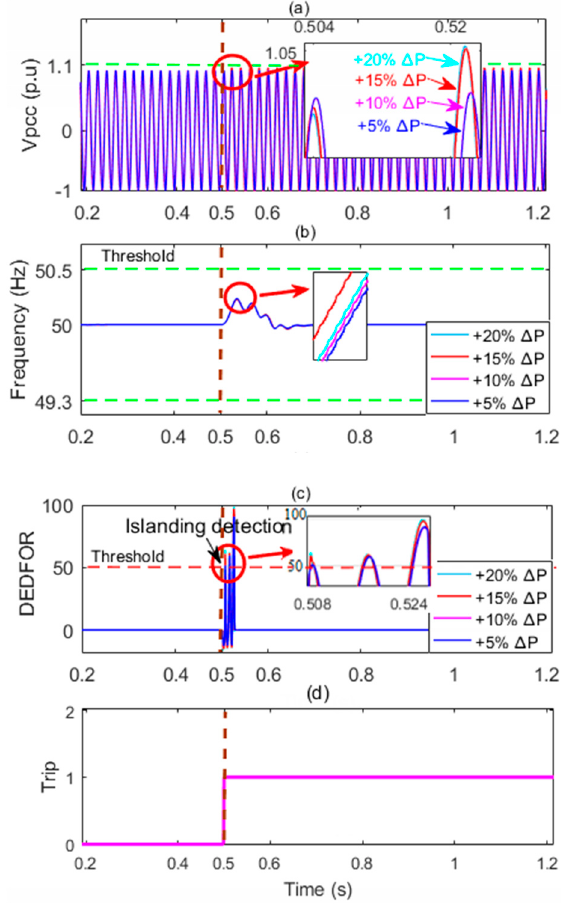
Figure 7. Case2, Scenario I: the results of analysis for increased active power mismatch. ( a )Voltage at PCC; ( b ) frequency at PCC; ( c ) output of the proposed DEDFOR detector; ( d ) the trip signal for CB1.